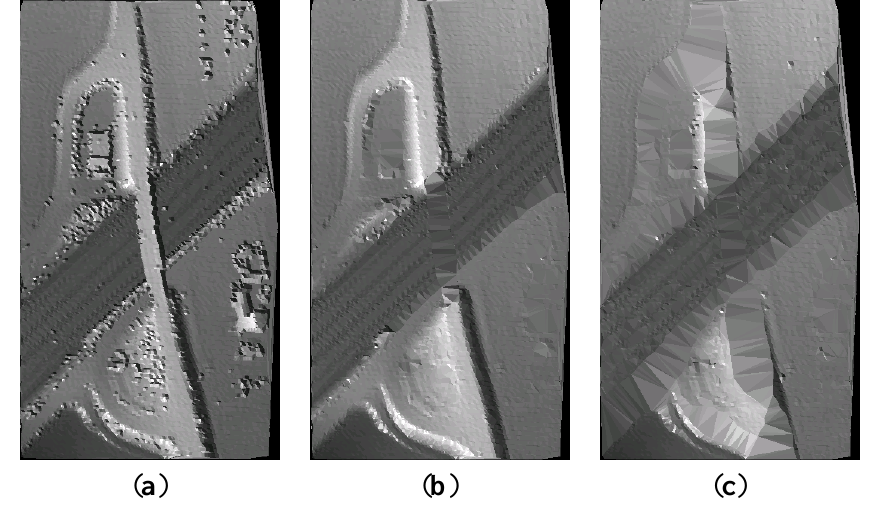
Figure 11. Filtering and results of reference data of Sample 71: ( a ) The DSM; ( b ) The reference DEM; ( c ) The DEM generated from the result of the PTD method; ( d ) The type I errors, type II errors of the PTD method; ( e ) The DEM generated from the result of the SBF method; ( f ) The type I errors, type II errors of the SBF method. Note that both of the DSM and the DEM are